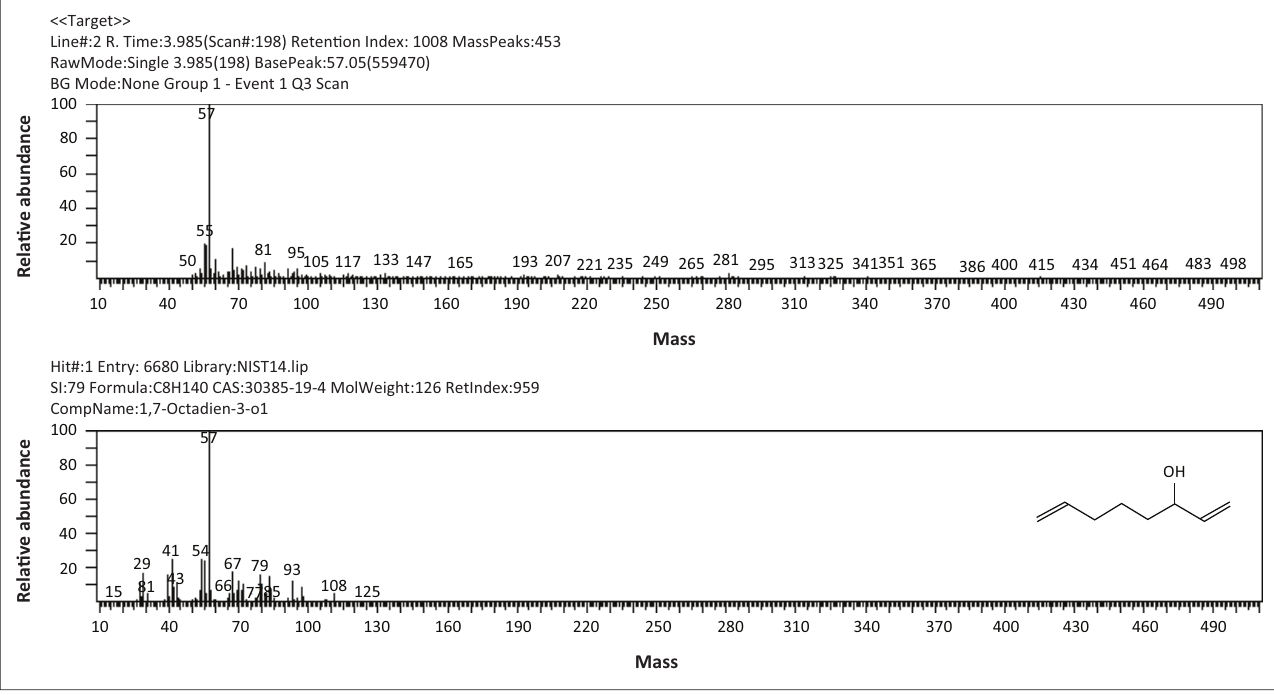
FIGURE 2: Gas chromatography–mass spectrometry spectra of 1,7-octadien-3-ol as identified with the help of an NIST spectral database